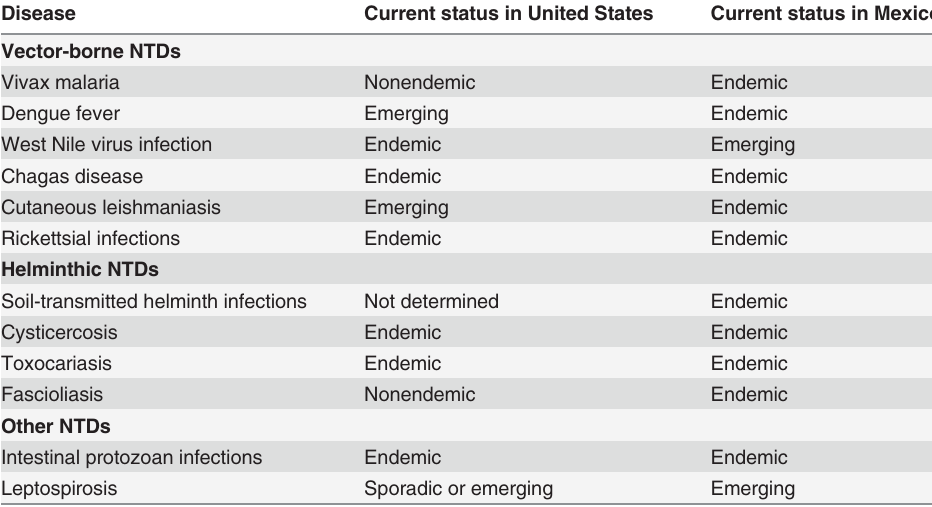
Table 1. Major NTDs affecting the Gulf of Mexico.